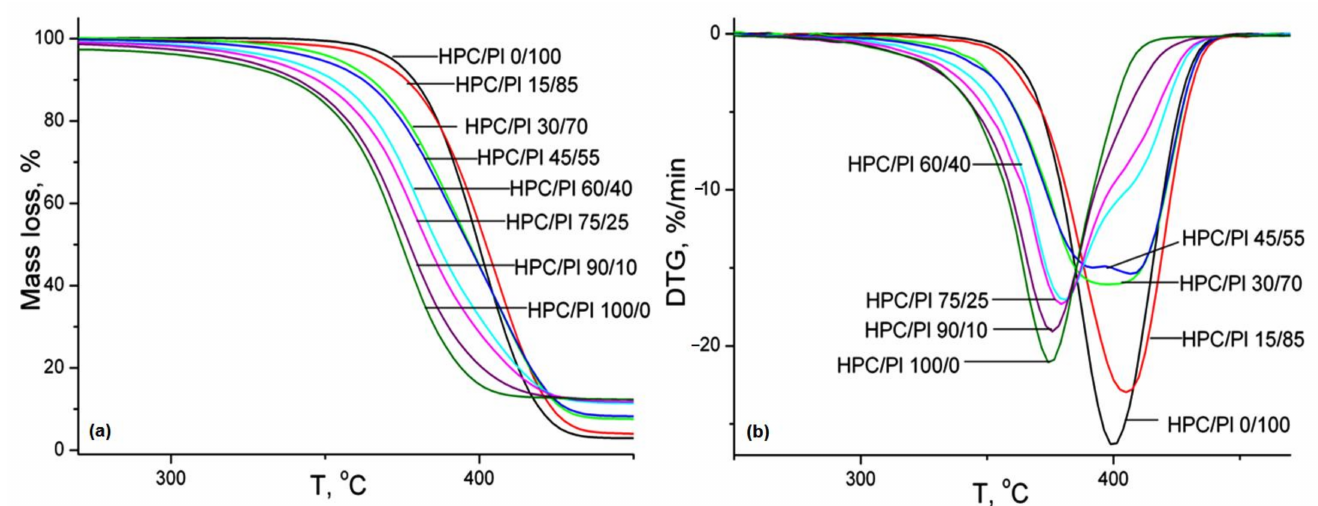
Figure 8. TG-( a ) and DTG-( b ) curves for the studied hydrogel blends. Table 5. Thermal characteristics obtained from the thermogravimetric analysis. Sample Stages ( ◦ C) n Pluronic F68